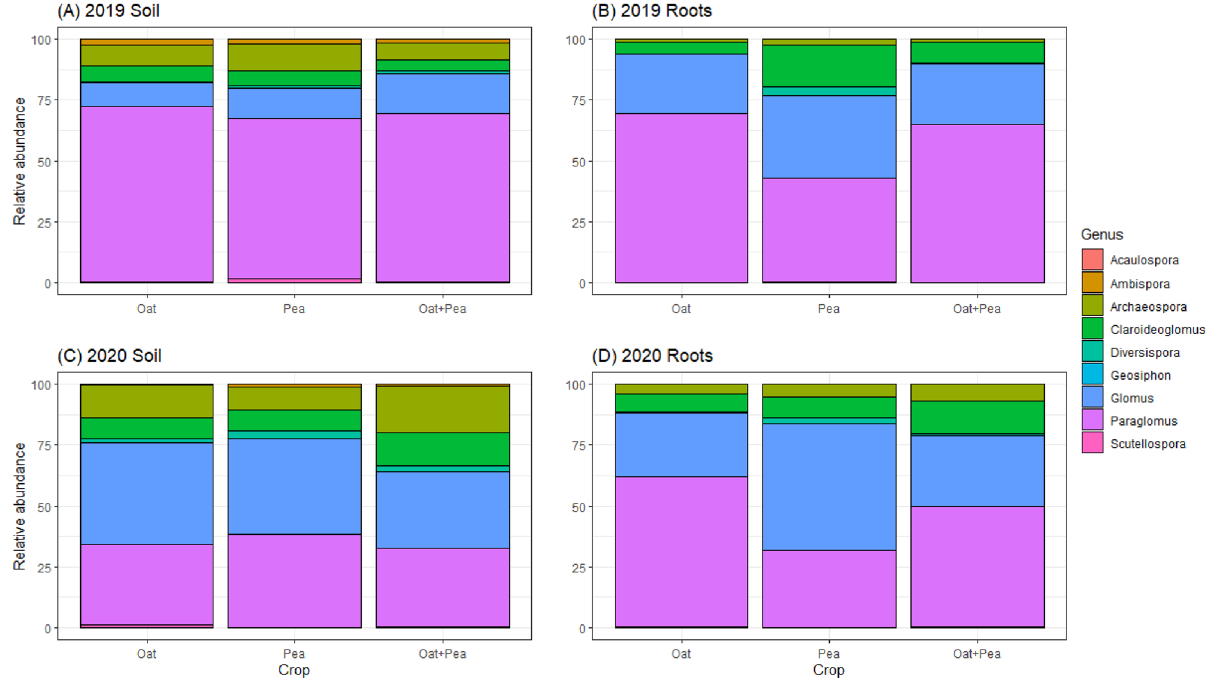
Figure 6. Proportional composition of AMF root and soil communities. Panel indicates proportional sequence abundance at site. Legend shows phylogenetic level to identified AMF